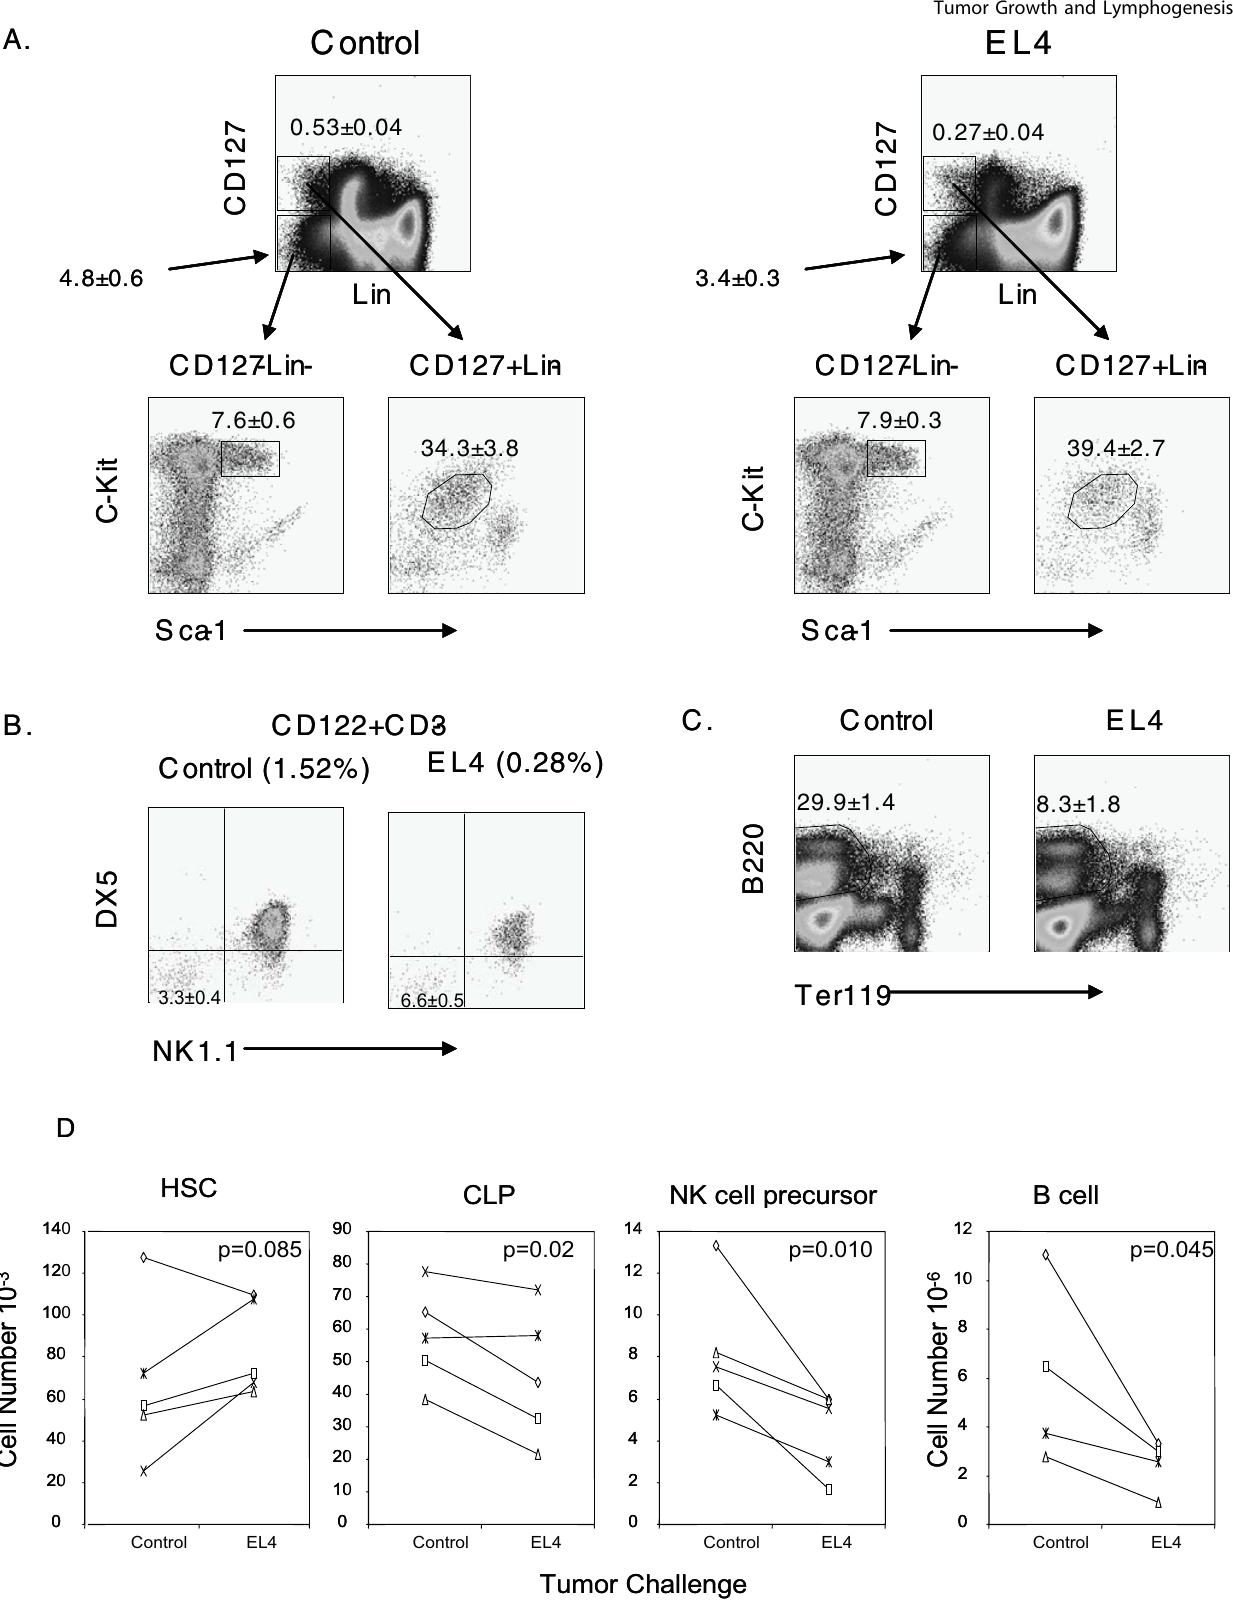
Figure 5. Altered lymphopoiesis. B6 mice were injected with PBS or EL4 and sacrificed after 21 days. A. FACs profile of early hematopoiesis. HSCs are characterized as Lin 2 CD127 2 Sca1 + cKit + while the CLP is characterized as Lin-CD127 + Sca1 + cKit + . B. Characterization of NKPs as CD3 2 CD122 + NK1.1 2 DX5 2 . C. Characterization of B cells by B220. D. Absolute numbers of HSCs, CLPs, NKPs, and B cells. Each line and symbol represents the mean of separate experiments involving 5 mice per group. A paired T test (one-tail) was used to determine whether tumor growth reduced the number of HSC, CLP, NKP and B cells. FACS data shown in A–C are representative of those obtained from 5 independent experiments, involving a total of 5 mice per group. doi:10.1371/journal.pone.0003180.g005 PLoS ONE |